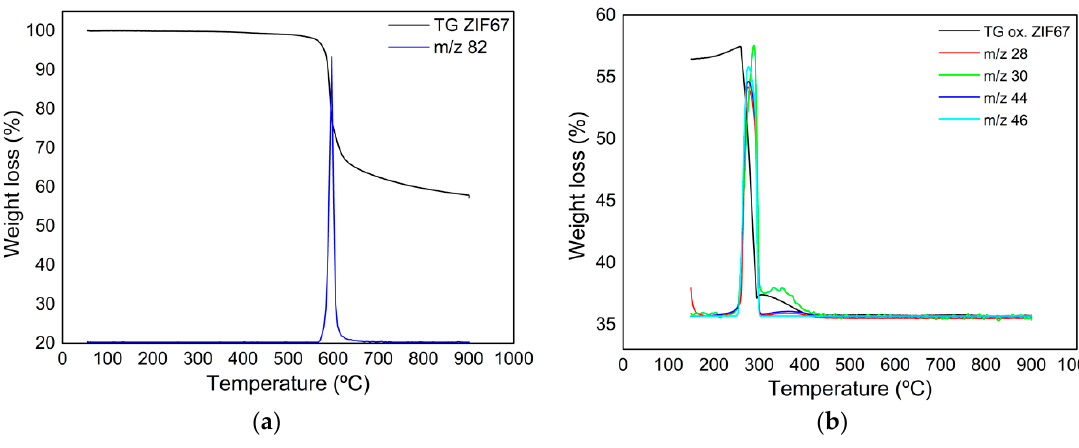
Figure A2. TGA-MS of sample ZIF-67. ( a ) In Ar, where m/z 82 is related with the